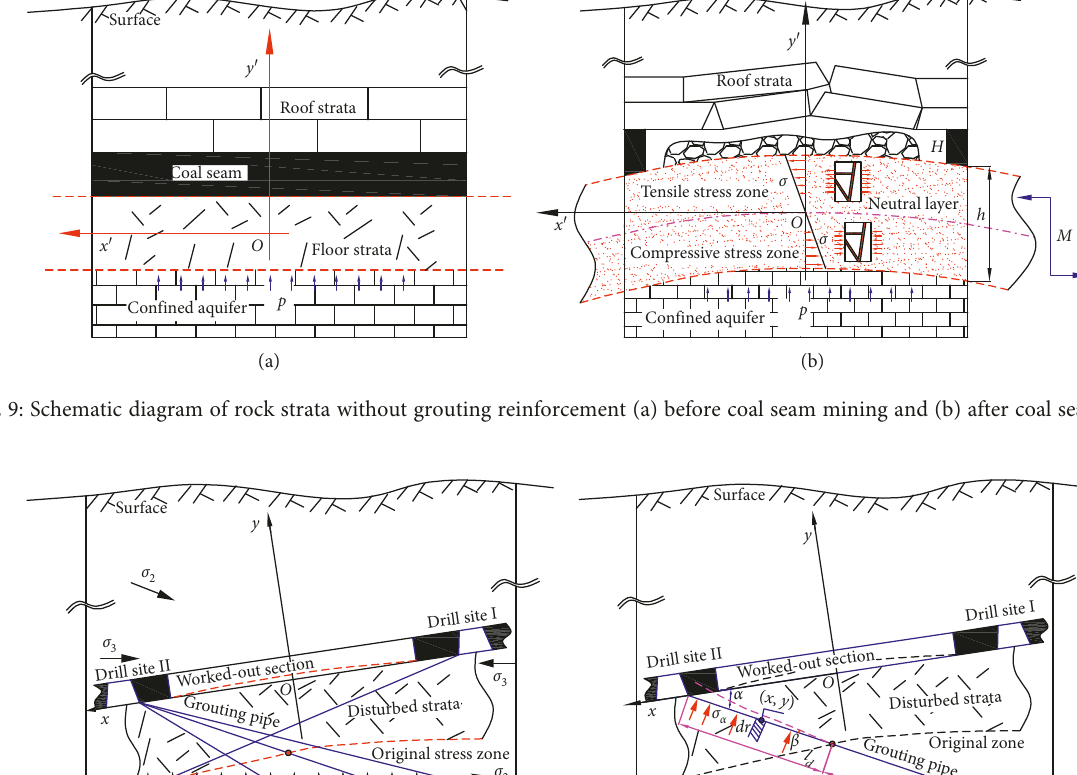
arranged in the floor rock masses, and the distances from coal seam floor to these two points are, respectively, 2 m and 15 m.